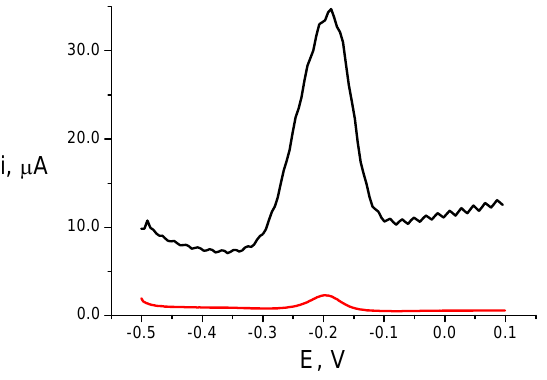
Figure 2. Stripping voltammograms obtained with the ss-DNA-EDC/NHSS-MPA-AuE after accumulation of MB. Supporting electrolyte: 50 mM Tris-HCl, 20 mM NaCl (pH 7.2). Accumulation conditions: [MB] = 20 µ M, t = 5 min, open circuit. Measurement conditions: SWV ( ⎯ ), E acc mV, f = 100 Hz, v = 500 mV s -1 , and DPV ( ⎯ ) 20 mV s -1 , ∆ E = 20